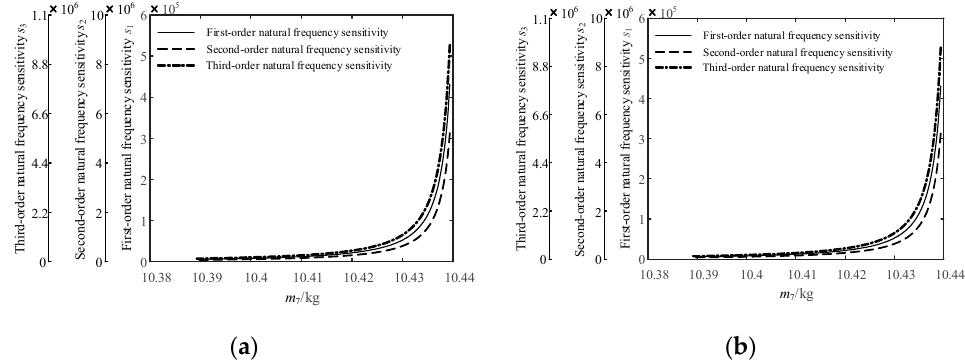
Figure 6. The variation law of the first three natural frequencies and their sensitivities of the jet system under a different initial gas content of the fluid with the mass of fluid unit 1. ( a ) Variation law of natural frequency sensitivity. ( b ) Variation law of natural frequency.